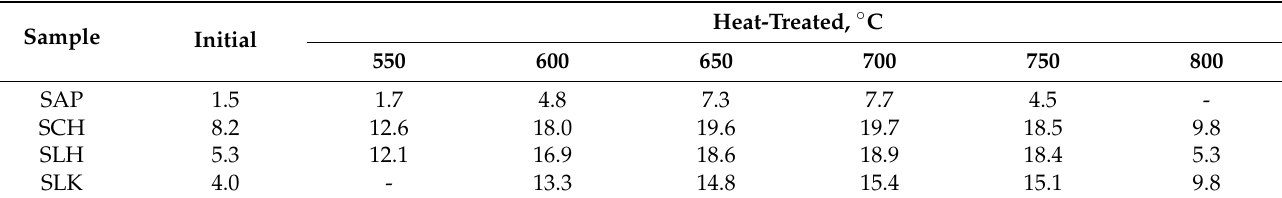
Table 2. Serpentines’ acid-neutralizing capacity, meq/g.